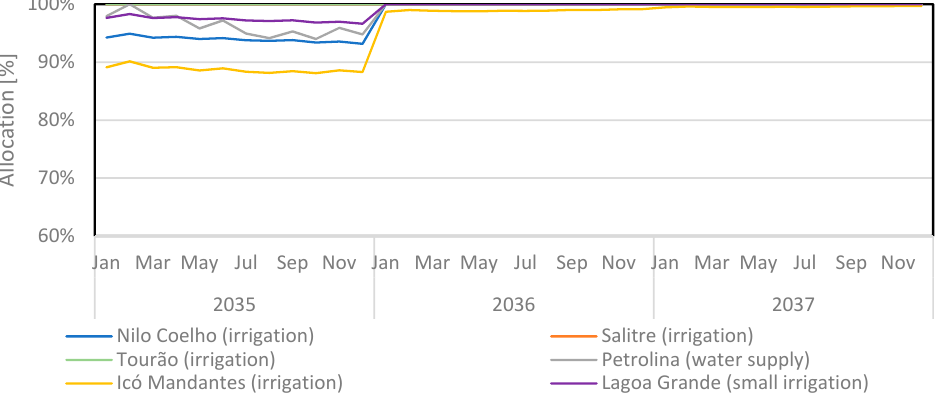
Figure 9. Optimization for water users in donor basin Water Allocation in scenario A2 period 2035–2037 irrigated projects, small irrigation, human supply.